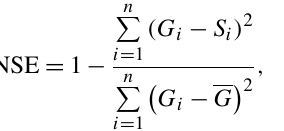
6. Repeat step (4) for k times where k is 100, 200, 500, and